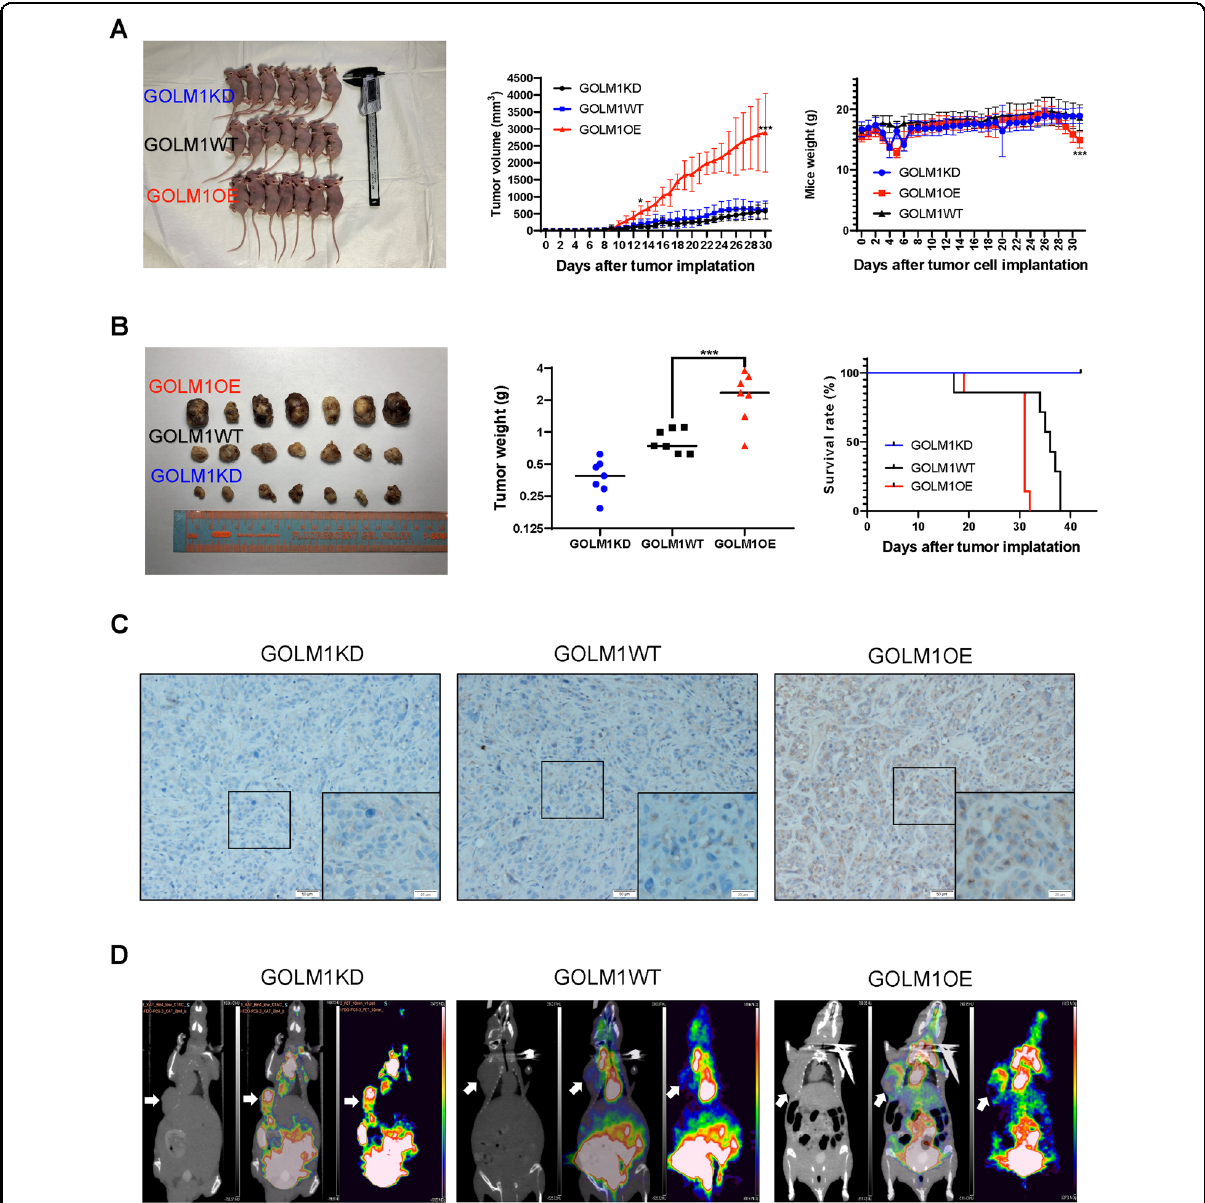
Fig. 5 GOLM1 expression is positively correlated with tumor growth in xenograft mice models of lung cancer. A Left: Tumors dissected from xenograft mice; middle: weights of tumors in three group; right: the tumor growth curve of xenograft collected from tumor bearing mice. B Left: photograph of xenograft mice; middle: weights of xenograft mice in three group; right: the survival curve of xenograft mice. C CT, 18F-FDG PET and 18F-FDG-PET/CT images and the maximum standardized uptake value (SUVmax) of xenograft mice. Tumor was pointed with white arrow. GOLM1KD GOLM1 knockdown group, WT wild-type group, GOLM1OE GOLM1 overexpression group. Data were means ± SEM. * P < 0.05, ** P < 0.01, *** P < 0.001, n =